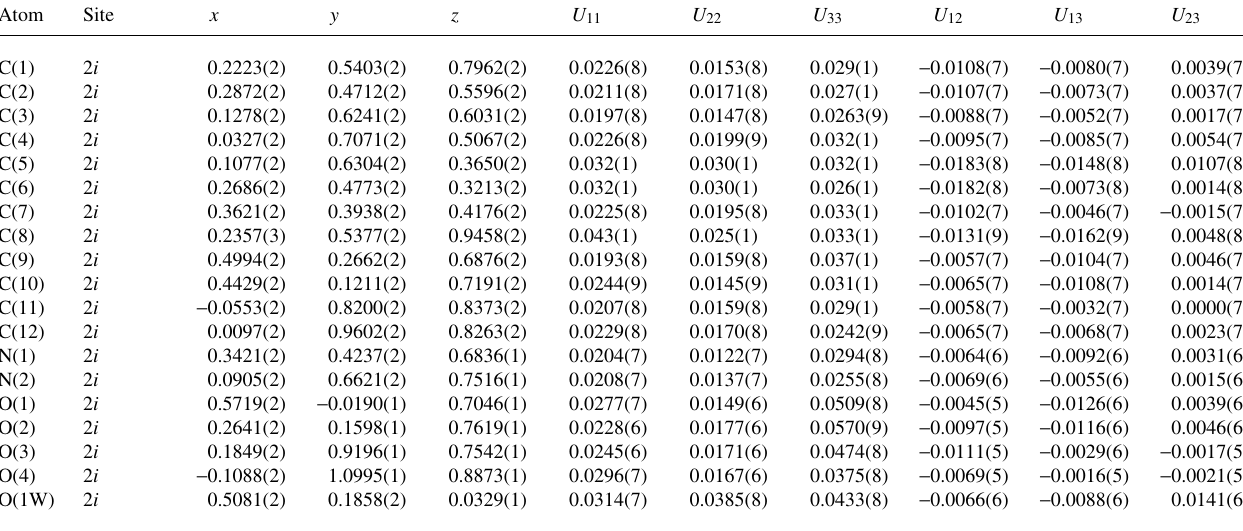
Table 3. Atomic coordinates and displacement parameters (in Å 2 ) .